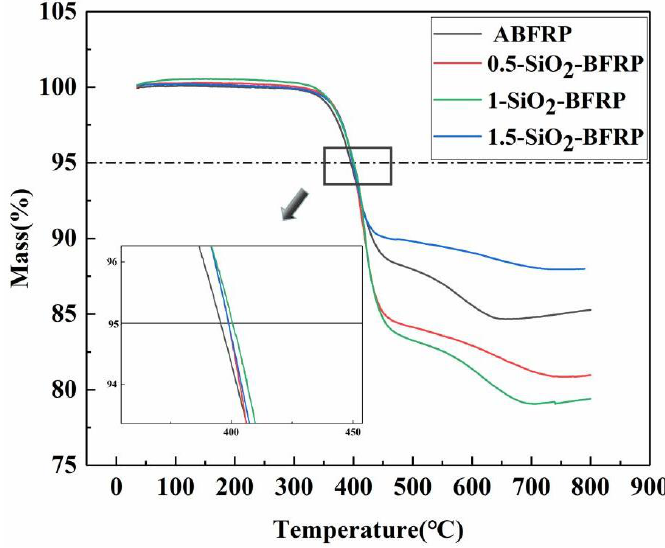
Figure 13. TGA experimental results of composites treated with SiO 2 -COOH at different concentra- tions.